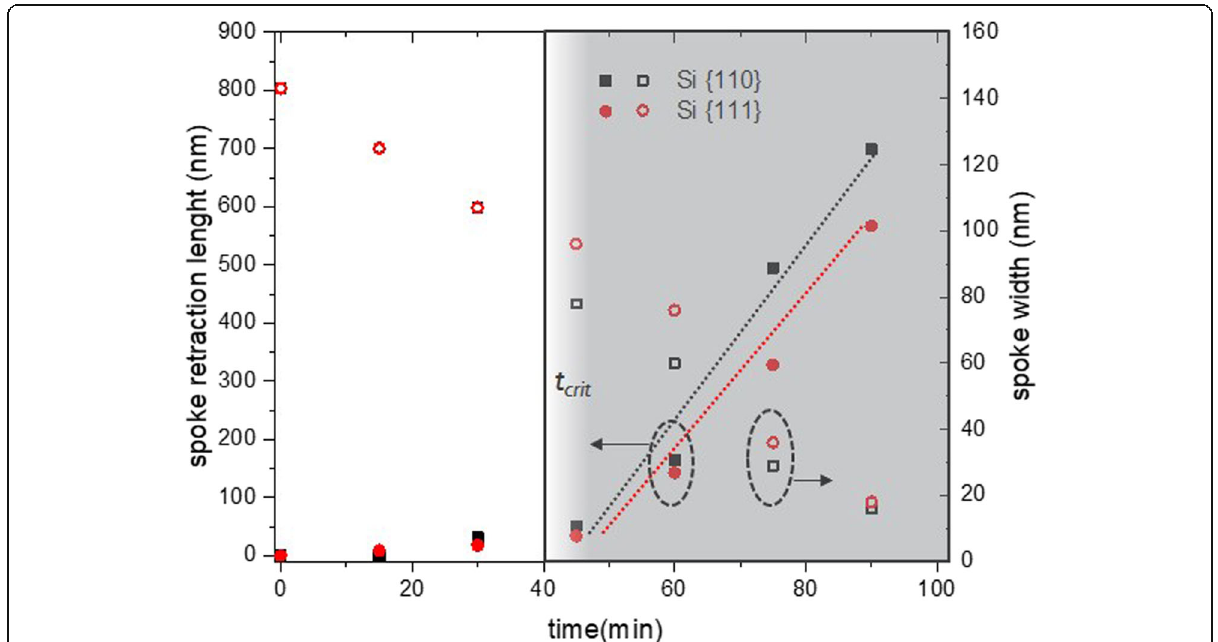
Fig. 9 Etching of Si spokes: the spoke width decreases gradually, but only after a certain tcrit., the spoke tips start to retract, and the measured retraction lengths can be fitted linearly a.f.o. etching time (gray-shaded